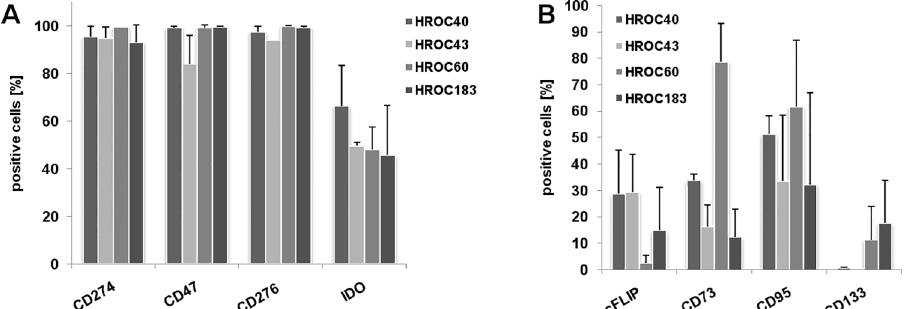
Fig 3. Immunosuppressive phenotype of CIMP + cell lines. Assessment of immune evasion markers was conducted by multi-color flow cytometry using fluorochrom-labeled mAbs as given on the x-axis. Results are given as the mean % of positive cells + standard deviation of three independent experiments.